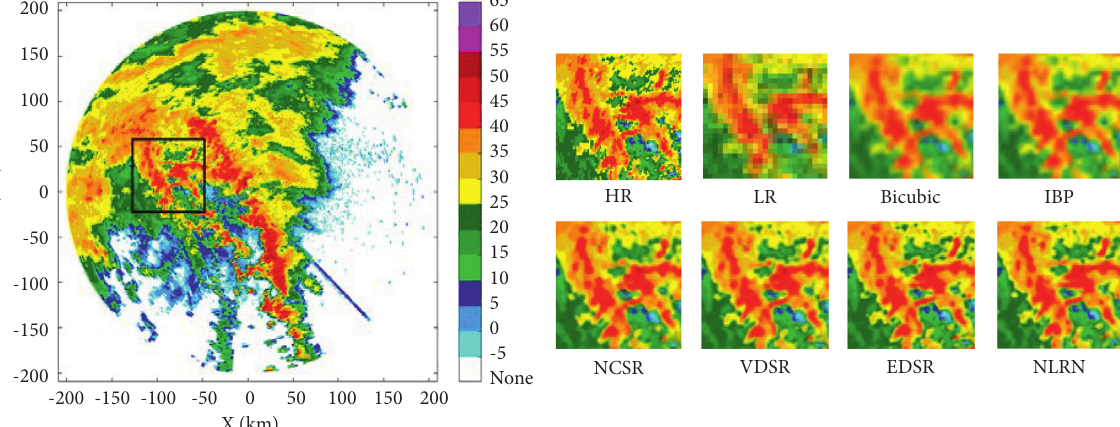
Figure 9: Visual comparison of × 4 super-resolution reconstruction results of typhoon data. The best results are in bold.